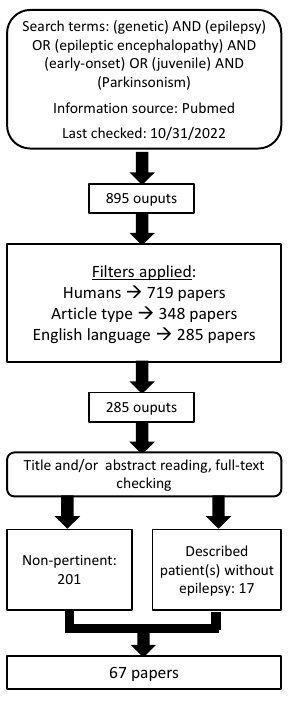
Figure 2. Flow chart depicting article selection process.